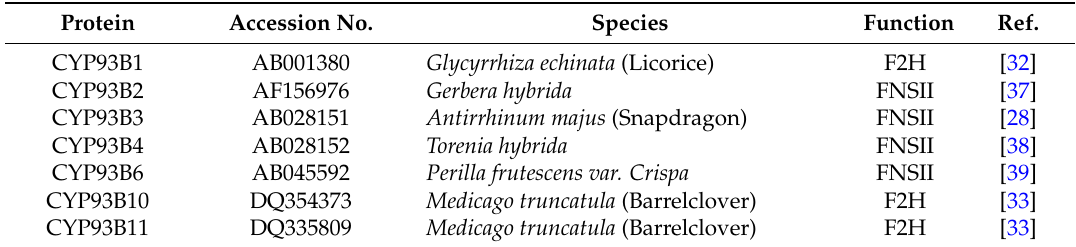
Table 1. Overview of functionally characterized plant FNSI, FNSII, and F2H enzymes. Protein Accession